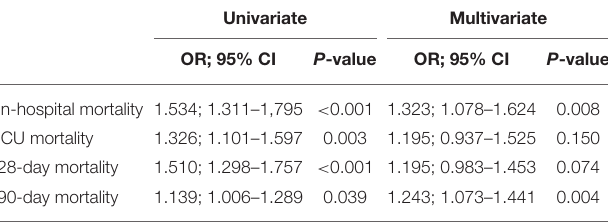
TABLE 4 | Univariate and multivariate logistic regression analysis of AF and mortality.